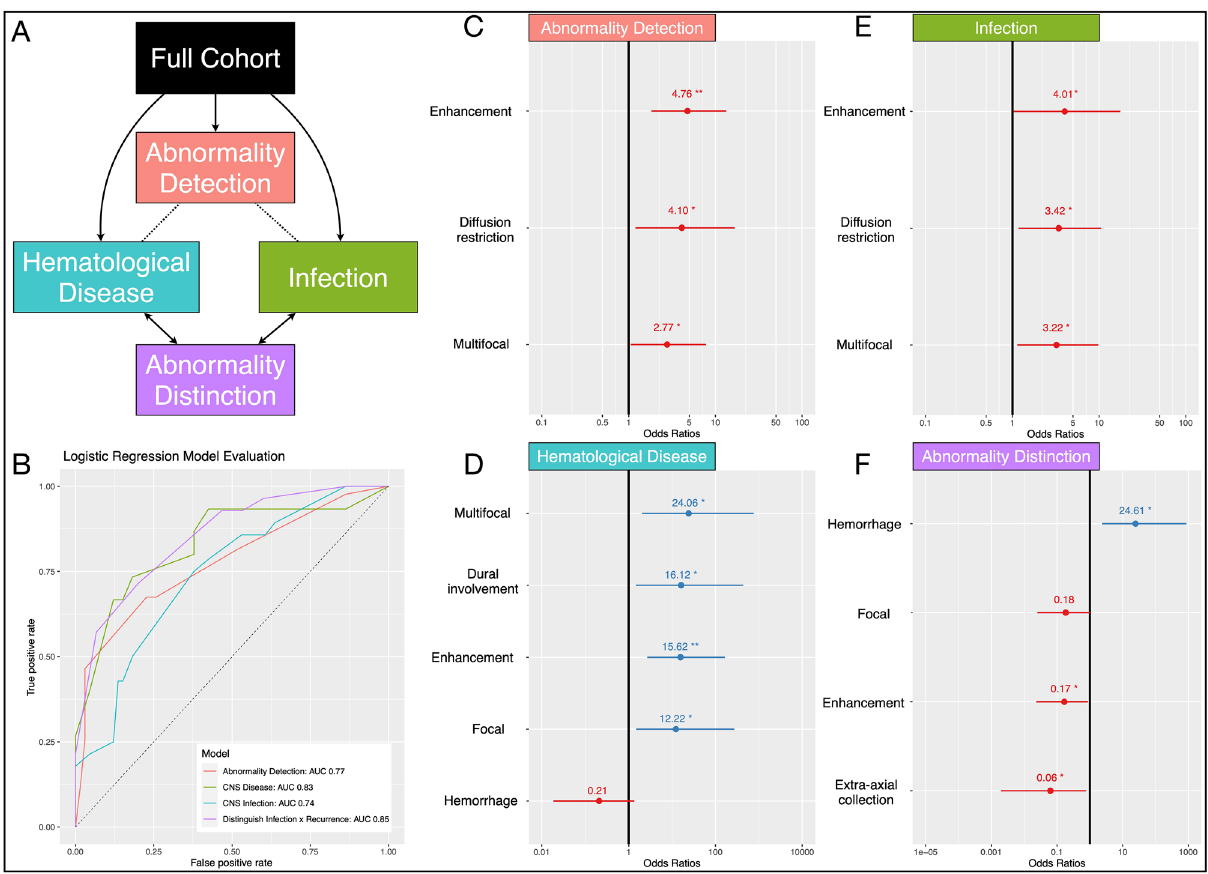
Figure 4. Modelling to identify and differentiate CNS hematological disease involvement and infection with imaging features alone. ( A ) Models were constructed with the aim to emulate the cognitive heuristic of a reading radiologist, wherein a first layer model of abnormality detection is derived, in this case identifying either of CNS hematological disease involvement or infection (red box). Following which, separate models to aid in the differential of either CNS hematological disease involvement (teal box) or infection (green box) are constructed to identify predictive features. Lastly, a model in effort to differentiate the two is built (purple box). ( B ) Receiver operator characteristic (ROC) plots of these four models, color coded as above. Beneficial features and Odds ratios with 95% confidence intervals for each model are shown on a log scale in ( C – F ). ( C ) Abnormality detection model identified three favoring features. ( D ) The CNS hematological disease involvement model identified 4 features favoring it (OR > 1) and one that made it less likely (OR < 1). ( E ) The CNS infection model identified 3 features favoring it. ( F ) The abnormality distinction model identified 1 feature favoring CNS infection (OR > 1) and 3 features favoring CNS involvement of the hematological disease (OR < 1). Asterisks correspond to p values as per conventional standards: ** p < 0.01,* p < 0.05. CSF cerebrospinal fluid, PCR polymerase chain reaction, WCC white cell